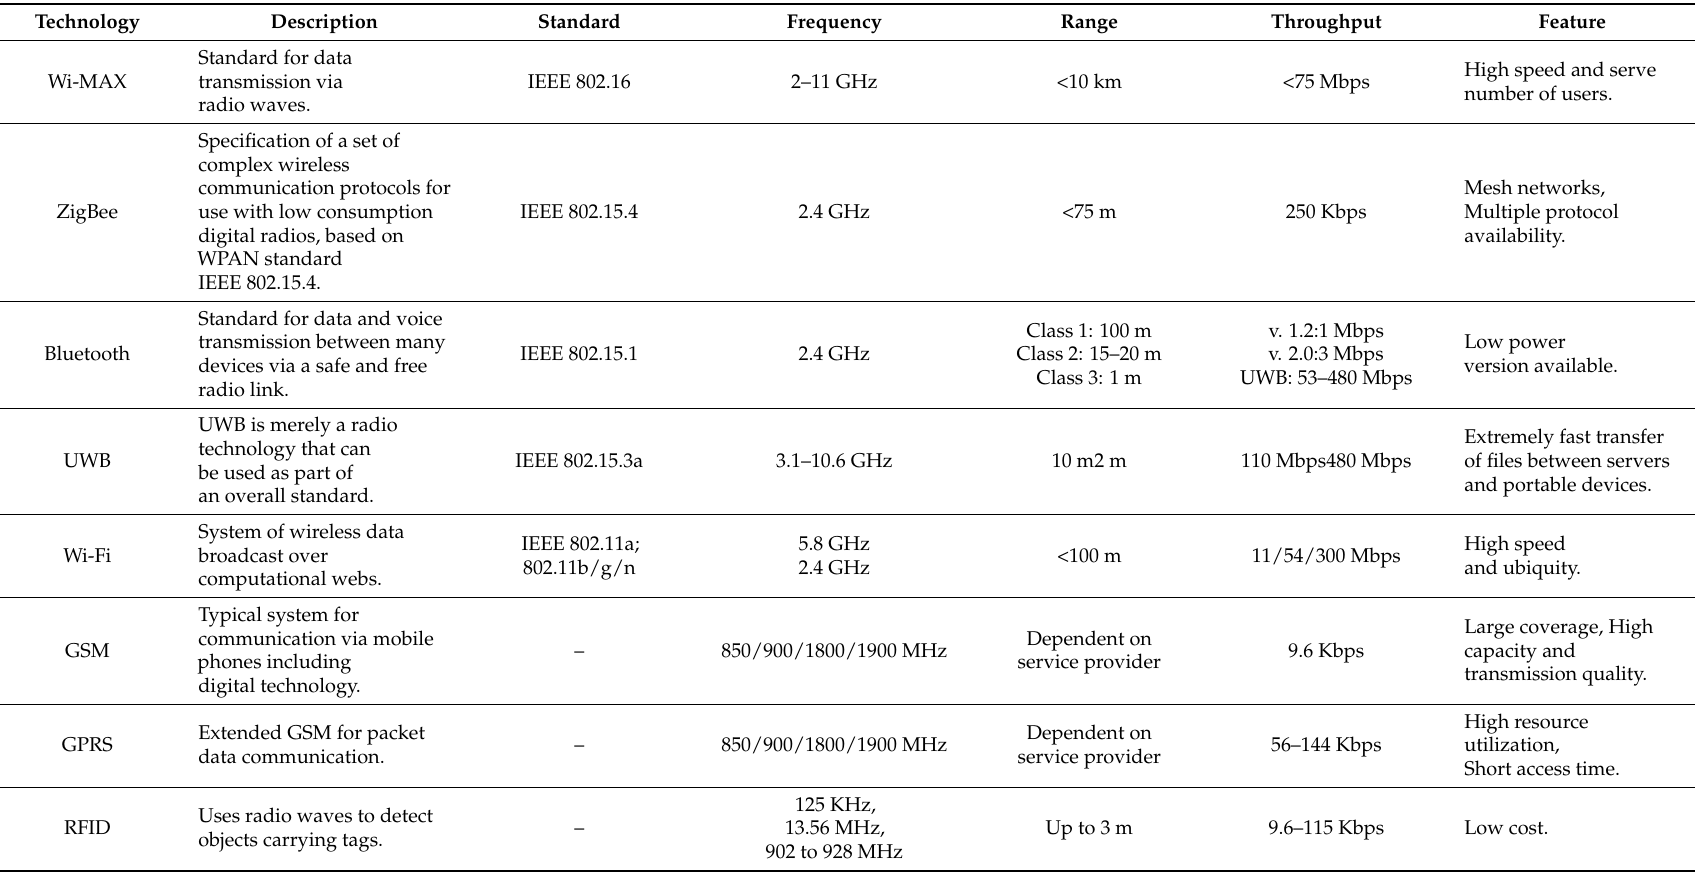
Table 3. Wireless Communication Technologies